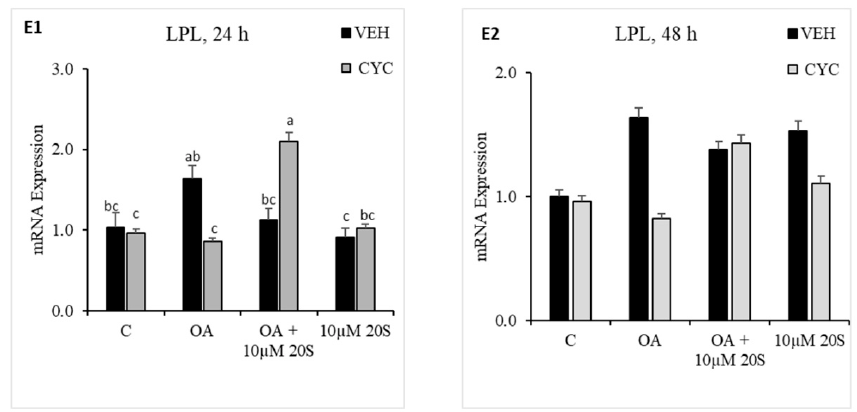
Figure 7. Hedgehog signaling pathway inhibitor, Cyclopamine, blocked the inhibitory e ff ect of 20S on OA-induced adipogenic di ff erentiation of chicken-bone marrow stem cells (cBMSCs). When confluent, cBMSCs were pretreated for 2 h with control vehicle (VEH) or 4 µ M cyclopamine (CYC) followed by 24 h and 48 h of treatment with (1) control vehicle ( C ), (2) Oleic acid (OA), (3) OA + 10 µ M 20S, or (4) 10 µ M 20S. RNA was isolated, reverse transcribed to cDNA, and q RT-PCR was conducted to analyze osteogenic gene expression. GAPDH was used as a housekeeping gene. Fold changes in gene expression relative to the control were calculated using the − ∆∆ Ct method. mRNA expression of ( A1 , A2 ) FABP4, ( B1 , B2 ) PPAR γ , ( C1 , C2 ) c / EBP α , ( D1 , D2 ) c / EBP β , and ( E1 , E2 ) LPL are presented above. Data from the representative experiment are reported as the mean of the triplicate determination. Bars represent mean ± SEM for triplicate determinations. Bars without a letter (a–b) in common are significantly di ff erent ( p < 0.05) when analyzed with Tukey’s